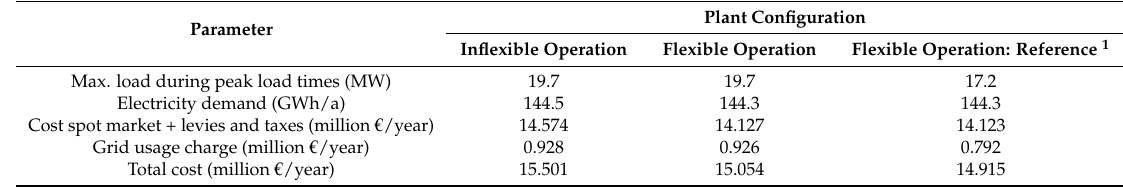
Table 1. Key parameters and results used to simulate different pumping and treatment plant configurations using values from